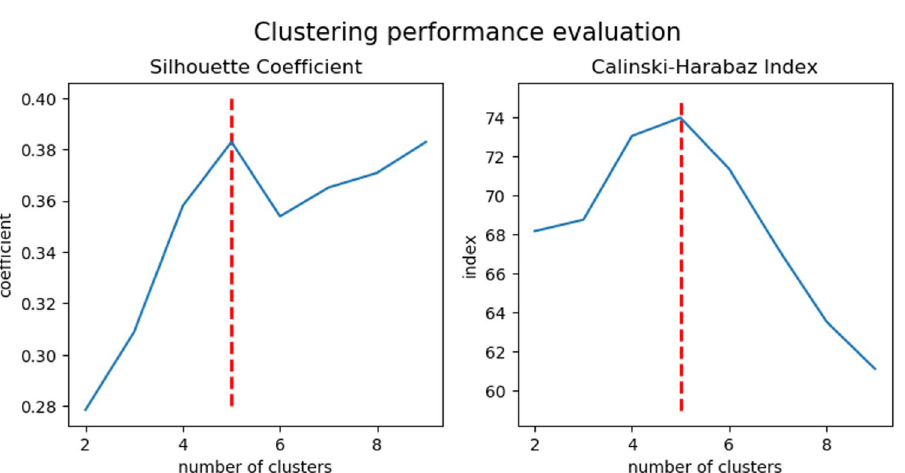
Figure 3. Lesion frequency map for each cluster in MNI-space. WMH in cluster 1 can be mainly assigned to Forceps Major, cluster 2 to right Anterior Thalamic Radiation, cluster 3 to Forceps Minor and 4 to the left Anterior Thalamic Radiation. Cluster 5 shows a high WMH burden and can be assigned to the right inferior fronto-occipital fasciculus. Clusters are shown as lesion probabilities from 0.0 to 0.5 (color scale on the right). The main WMH corresponding to specific WM tracts (copper color) are emphasized with red arrows.